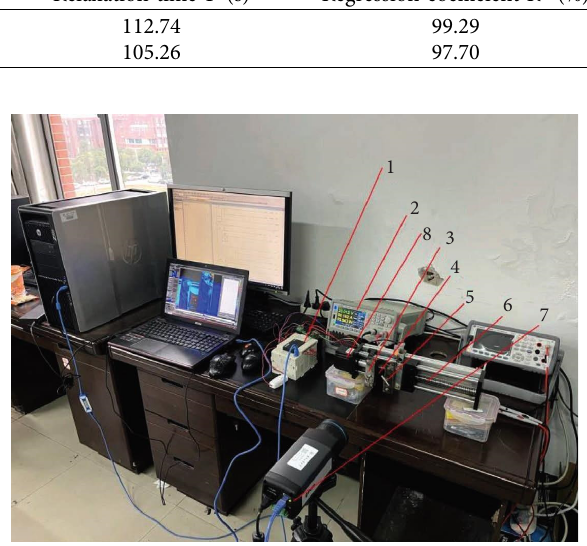
Figure 6: Fatigue tests platforms based on the thermal-graphic